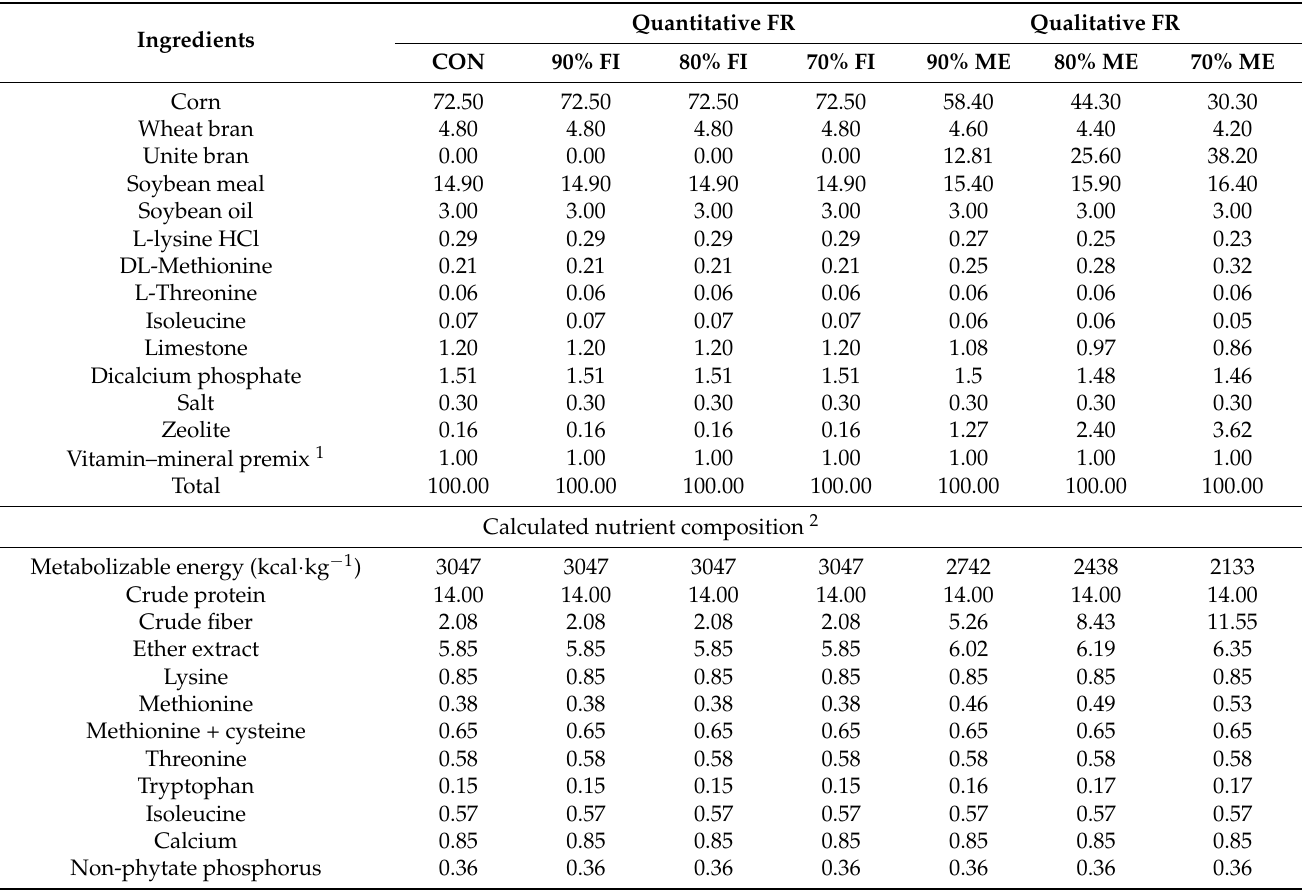
Table 1. Dietary composition and nutrient level of Bearded chickens in each treatment group at the finisher phase (DM basis,